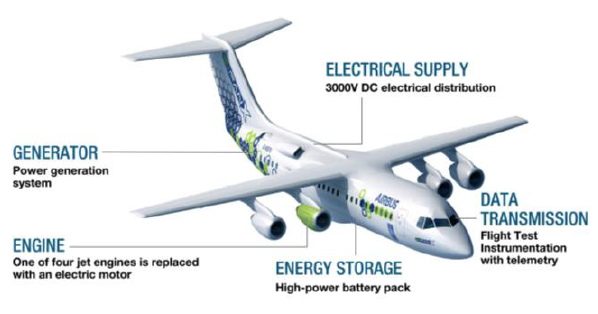
Fig. 3. The E_Fan X aircraft